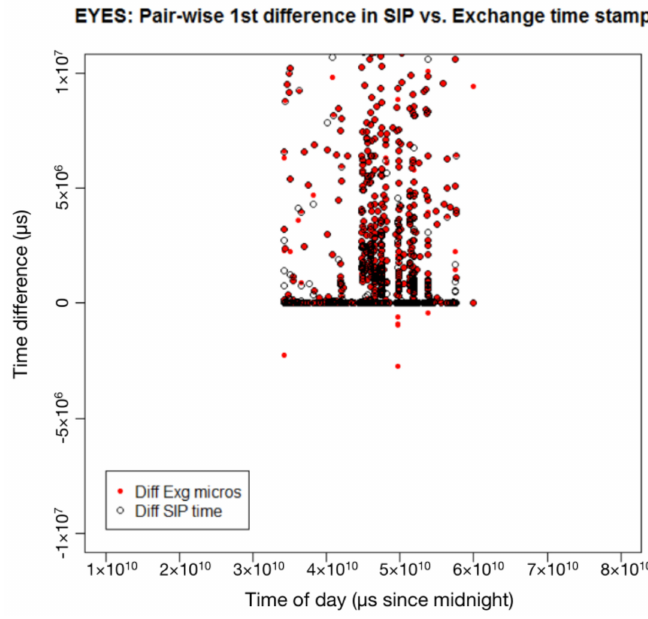
Figure 19. Time difference in SIP vs. exchange time stamp for EYES stock on 11 August 2015.